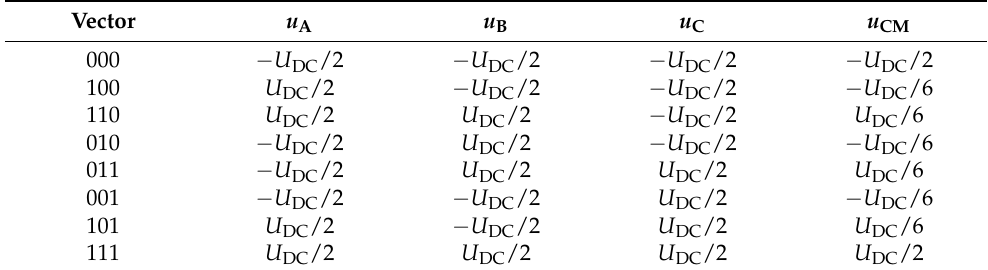
Table 1. Summary of the common-mode voltage u CM values for individual control vectors.